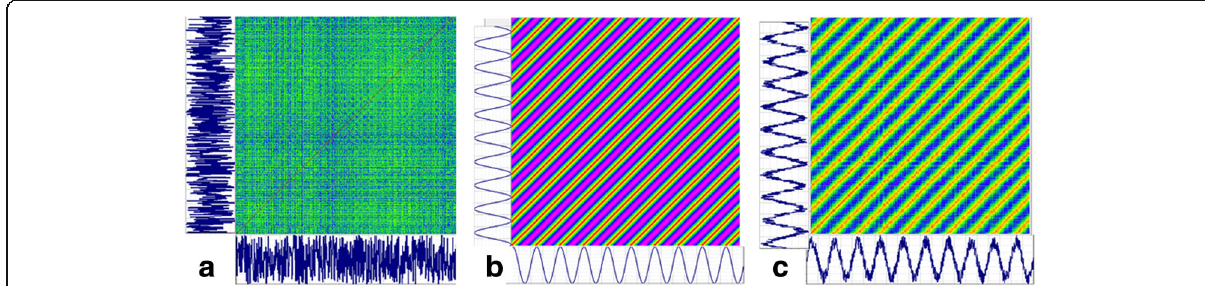
Fig. 1 Examples of recurrence plots. a White noise. Any patterning occurs by chance. b A sine-wave with no noise. The vertical (or horizontal) distance between red lines is the period of the signal. c A sine-wave with noise. The signal is blurred and there is a faint underlying patterning of horizontal and vertical lines but the overall pattern of diagonal lines is preserved